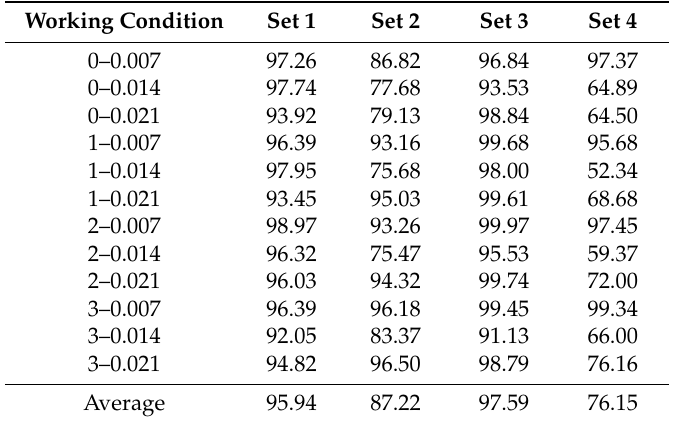
Table 5. Average diagnostic accuracy to all independent experiments corresponding to 12 different working conditions respectively with the scheme (5/95) in 1st–4th experiment sets.